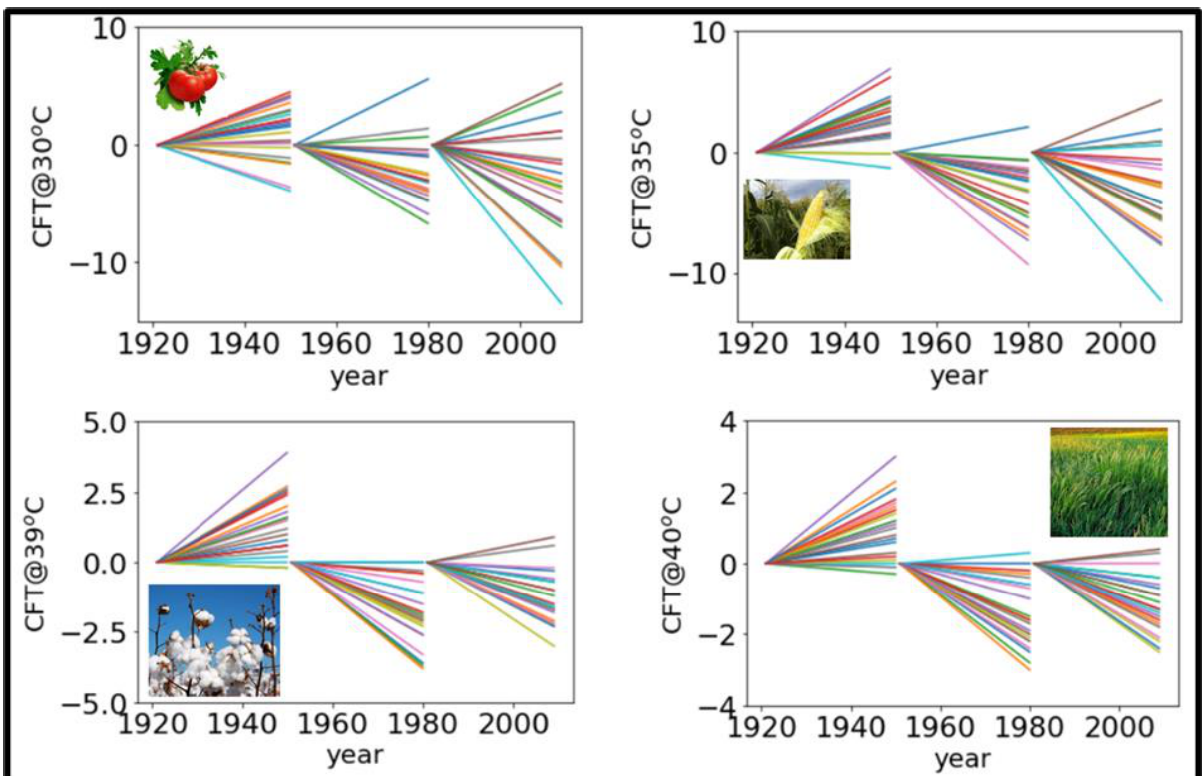
Figure 8. Linear trends (colored lines) in the number of days with CFT at four different temperatures, clockwise from the top, at 30 °C, 35 °C, 39 °C, and 40 °C for the Kansas stations shown in Figure 1c.